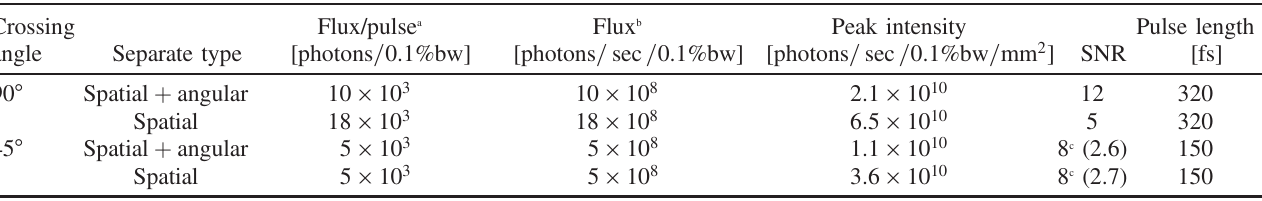
TABLE III. Separation performances of hard x-ray synchrotron radiation from electron beam slices. Data are recorded at 7.8 KeVon the observation